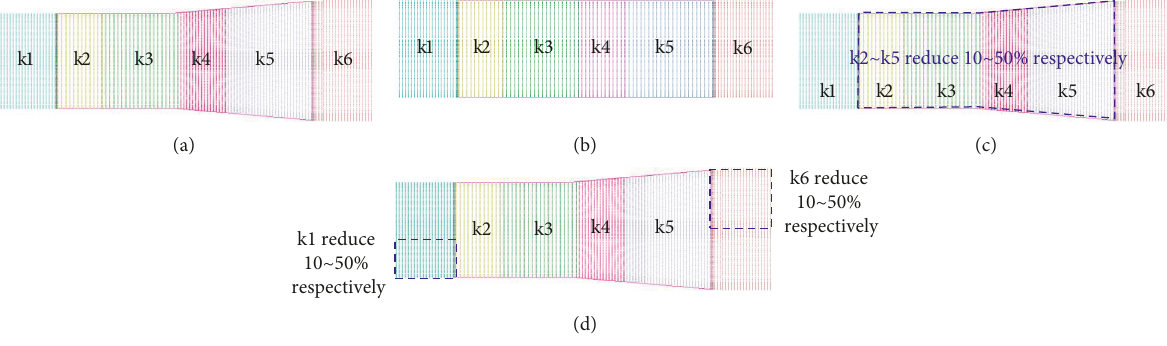
Figure 5: The diagram of (a) working condition 1 with a variable cross section, (b) working condition 2 with a uniform cross section, (c) working conditions 3–7, and (d) working conditions